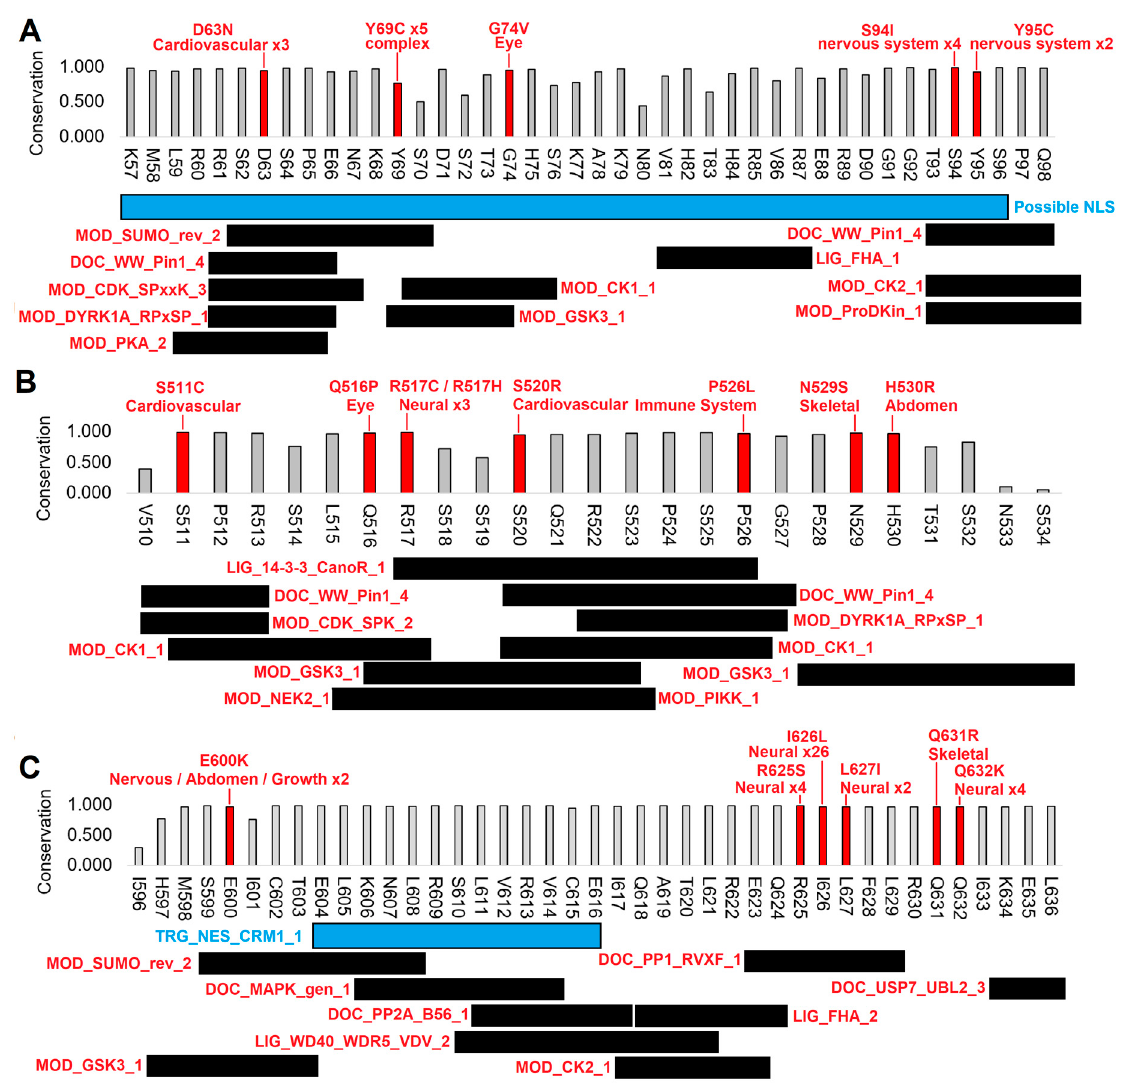
Figure 3. Highly conserved motifs within WAC containing human variants connected to medical phenotypes. Shown for the N-terminal nuclear localization motif ( A ), central 14-3-3 interaction motif ( B ), and the C-terminal nuclear export motif region of the coiled-coil domain ( C ). The conservation is based on the 364 amino acid sequences of vertebrate WAC (0—no conservation, 1–100% conserved). Those amino acids in red have a known Geno2MP variant with listed phenotypes. Those with multiple individuals with overlapping phenotypes are represented with an x number of individuals. Below each region are ELM-predicted motifs.